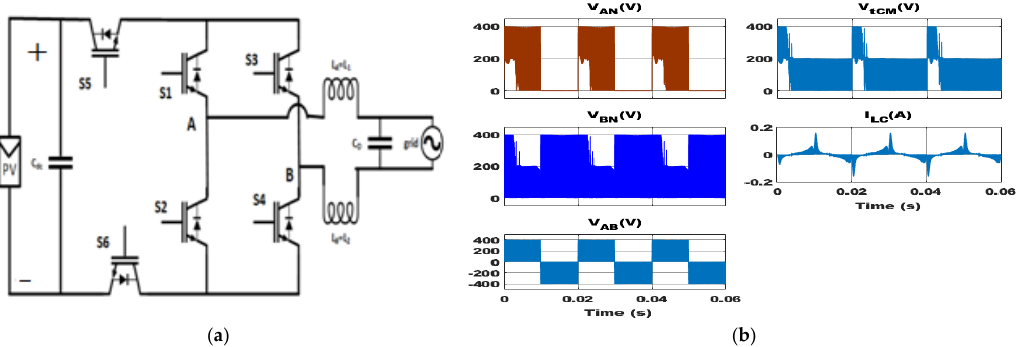
Figure 8. Improved H6 topology: ( a ) circuit structure; ( b ) simulation results.